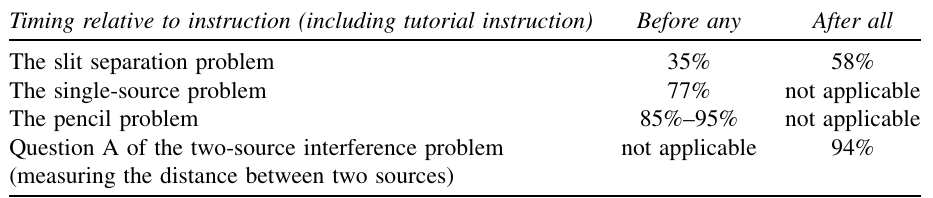
TABLE VI. Percentage of correct answers with correct reasoning for several tasks given at UW either before any instruction on two-source interference or after all instruction, including tutorial instruction. (Some of these data also appear in other tables; they are repeated here to facilitate